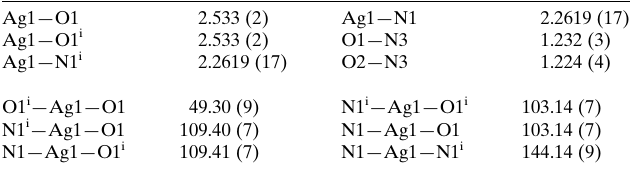
Table 2 Experimental details. Crystal data Chemical formula